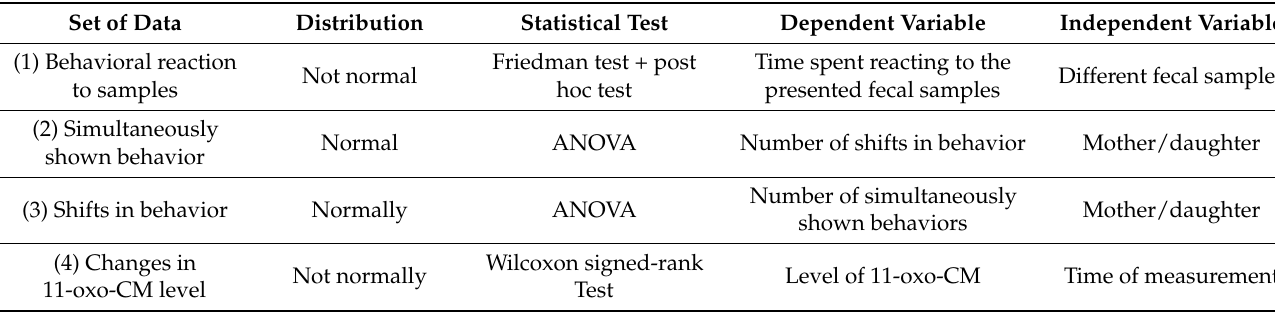
Table 3. Overview of statistical analysis.